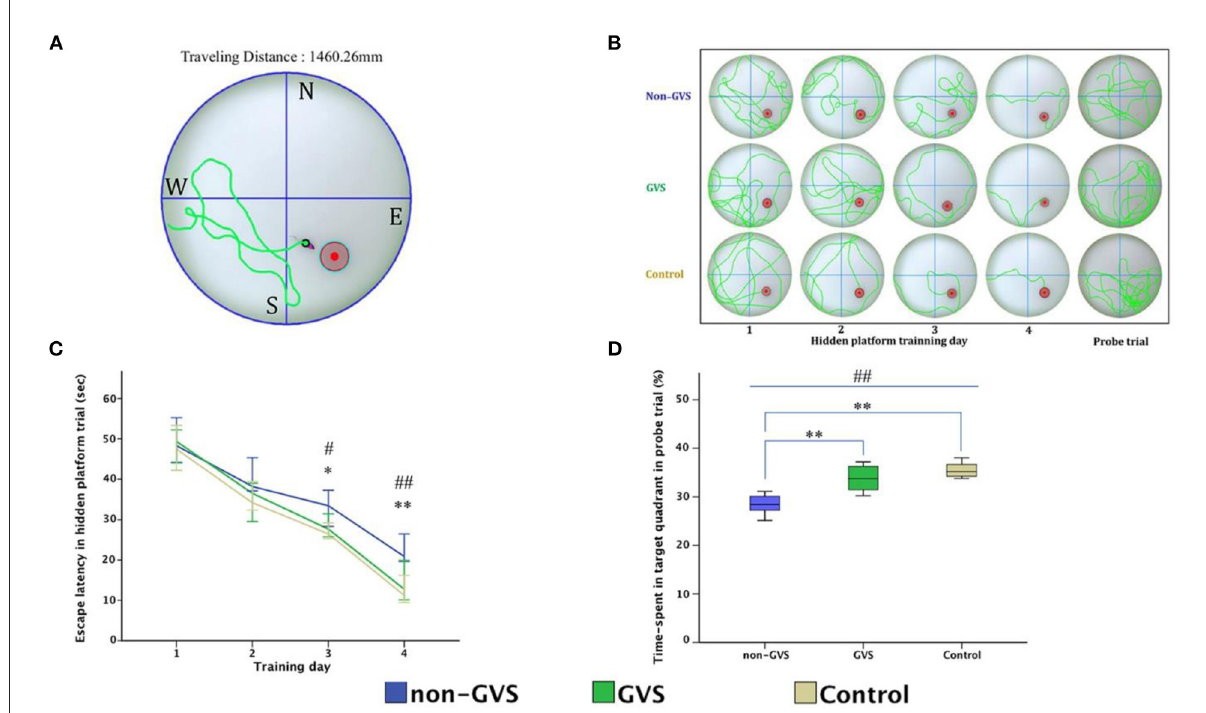
FIGURE4 Evaluation of motor coordination and spatial navigation of mice through the Morris water maze (MWM). The analysis package divided the searching area into four quadrants, one of which contains the escape platform (red circle) (A) . The process of finding the escape platform from the starting point was tracked in the mice (pink) for 1min (A) . Mice were trained with the visible platform at post-operative day (POD) 8 (not depicted) and hidden platform for 4 consecutive days (POD 10–13) and no platform in the probe trial at POD 14 (B) . Longer values of escape latency to find the hidden platform indicate an inadequate acquisition of spatial memory and navigation, which showed differences between groups at the last two training days ( χ 2 = 6.54, p < 0.05 and χ 2 = 10.52, p < 0.01, Kruskal–Wallis test). Non-GVS mice had a longer escape latency (33.5s on the third day and 20.9s on the fourth day of hidden platform trials) than those of the GVS group (27.67s, Z = − 2.07, p < 0.05 on the third day and 17.39s, Z = − 2.73, p < 0.01 on the fourth day) and the control group (26.47s, Z = − 2.19, p < 0.05 on the third day and 11.25s, Z = − 2.61, p < 0.01 on the fourth day) (Mann–Whitney U- test) (C) . During the probe trial at POD 14, there was a significant decrease in the percentage of time spent in the target quadrant in the non-GVS mice [28.5% (26.2–30.6%)] compared to the control group [35.2% (34.0–37.3%), Z = − 2.61, p < 0.01, Mann–Whitney U- test] (D) . GVS intervention substantially enhanced recovery of this deficit [33.7% (30.9–36.5%), Z = − 2.73, p < 0.01, Mann–Whitney U- test], and they were no different from the control group (D) . *Significantly different between two groups; # Significantly different between three groups; * , # p < 0.05; ** , ## p < 0.01. Values of significant difference were calculated by using the Kruskal–Wallis test for between groups and the Mann–Whitney U- tests for pairwise comparisons. Reproduced from Nguyen et al.